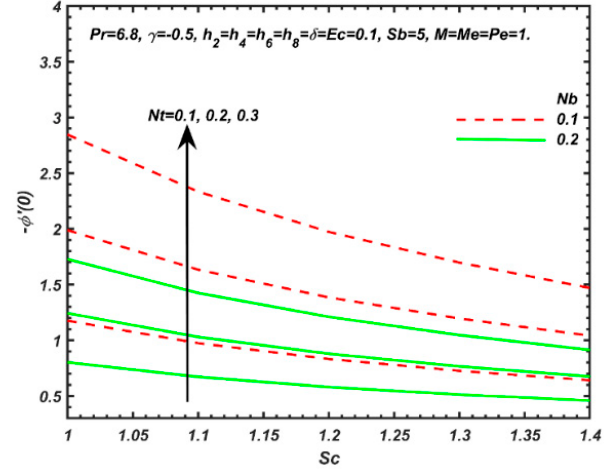
Figure 10. Local Sherwood number, − φ (cid:48) ( 0 ) versus Sc and Nb for di ff erent values of Nt ( ) 0 φ′− versus Sc and Nb for different values of Nt .